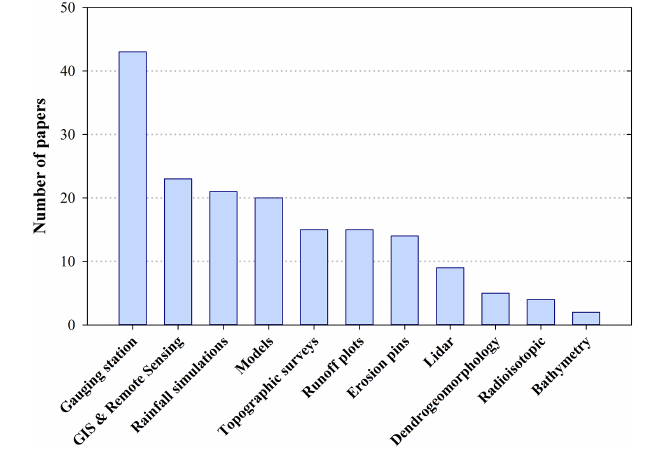
Figure 1. Distribution of soil erosion studies in badland areas ac- cording to different methodologies.